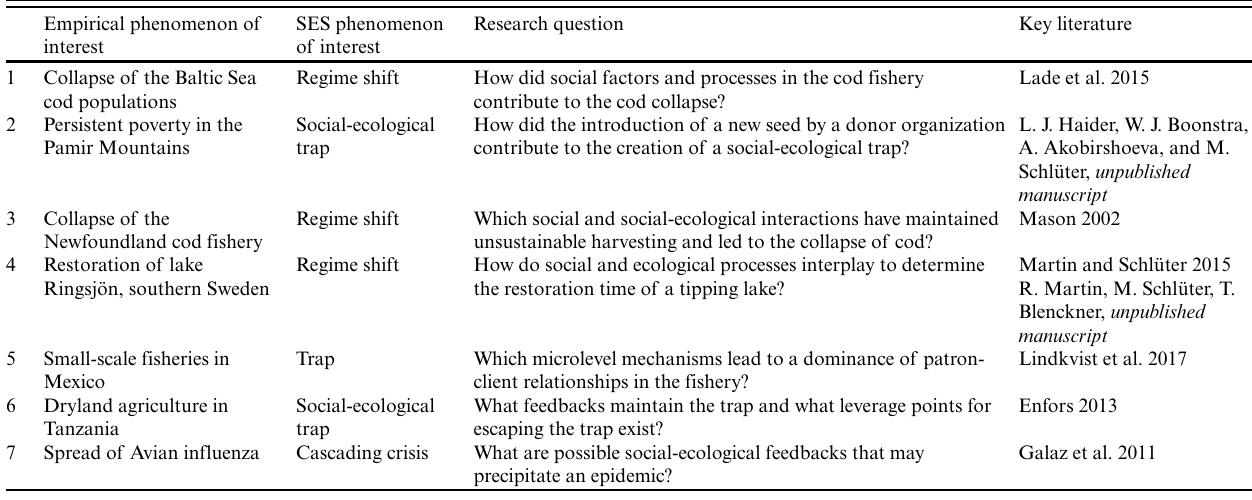
Table 2 . List of case studies that were analyzed using the social-ecological action situations (SE-AS) framework. The first two cases are presented in the main text (Baltic Cod and Pamir Mountains), the others are in Appendix 1. Cases 3,6, and 7 are based on the review of literature on the case, whereas cases 1, 2, 4, and 5 are an outcome of empirical research performed by authors (see key literature for relevant publications). Note: SES = social-ecological system.